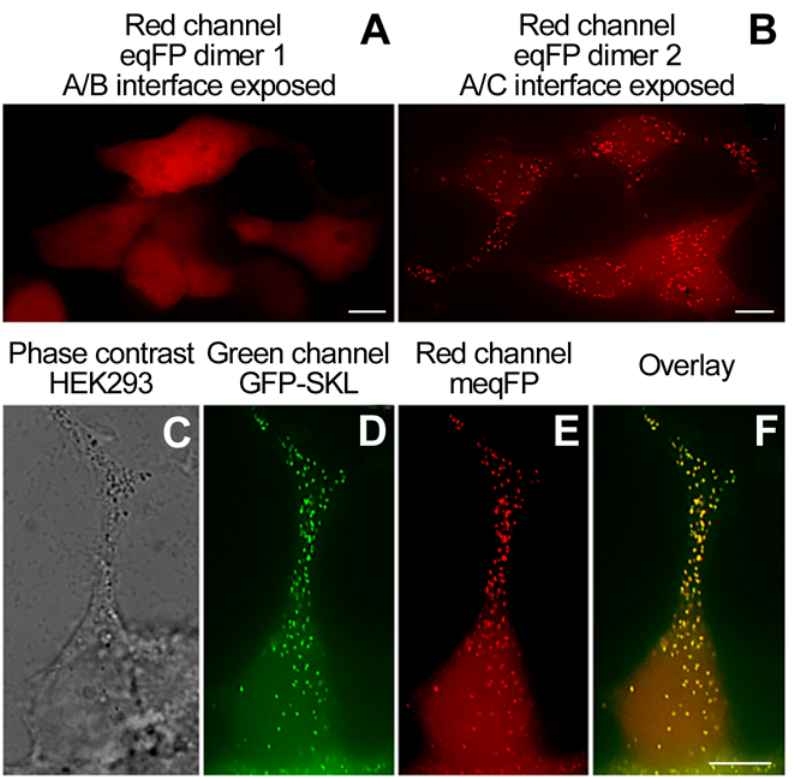
Figure 1. Subcellular localization of eqFP611 variants in HEK293 cells. (A) The eqFP dimer 1 (RFP611 T122R) [14] is evenly distributed over the cell. (B) The enhanced eqFP dimer 2 (T122G, F194A) shows a granular localization. (C–F) Cells co-expressing EGFP-SKL and an enhanced monomeric eqFP611 (T122R, F194A) variant show co-localization of green and red fluorescence in the peroxisomes. (C) Phase contrast image. (D) Green-channel image acquired with a standard FITC filter set. (E) Red-channel image produced with a standard TRITC filter set. (F) Overlay image of the green and red channels. Bars: 2.5 m m.